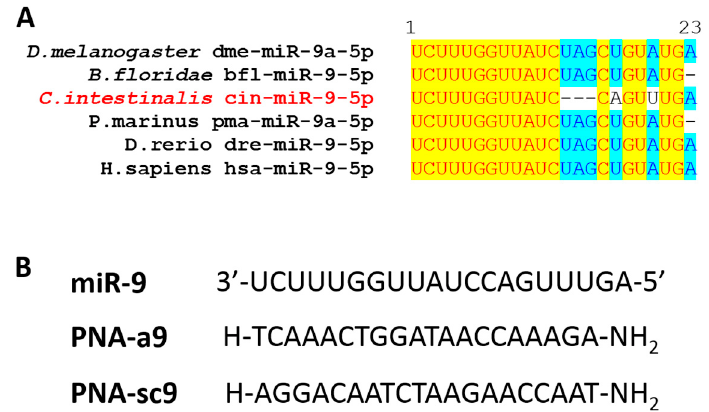
Figure 1. ( A ) Multialignment of miR-9 from different species. Identical residues are highlighted in yellow, and those conserved in at least 50% of sequences in light blue. The mature miR-9 sequences were retrieved from miRBase: dme-miR-9a-5p: MIMAT0000114; bfl-miR-9-5p: MIMAT0009465; cin-miR-9-5p: MIMAT0016396; pma-miR-9a-5p: MIMAT0019373; dre-miR-9-5p: MIMAT0001769; hsa-miR-9-5p: MIMAT0000441. ( B ) PNA sequences used in this study: PNA-a9 and PNA-sc9.